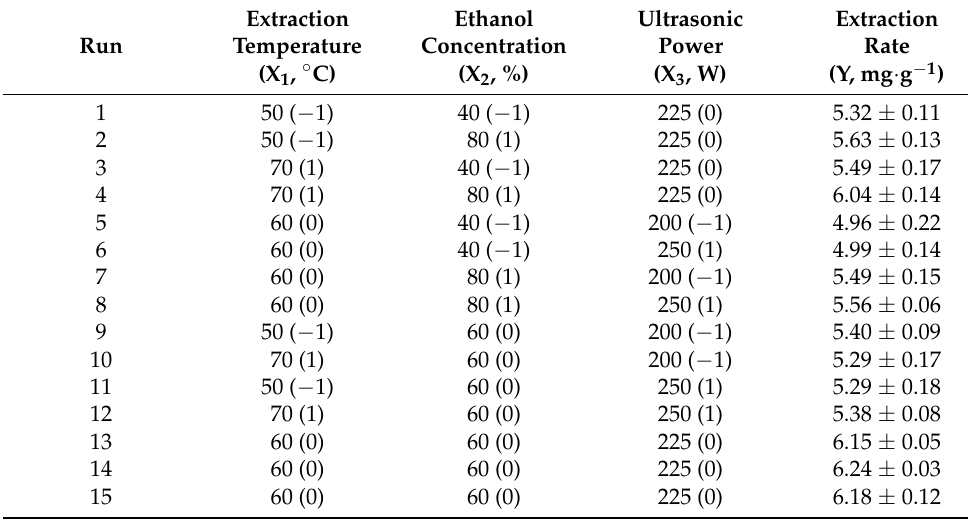
Table 2. Design matrix and results of BBD experiment.